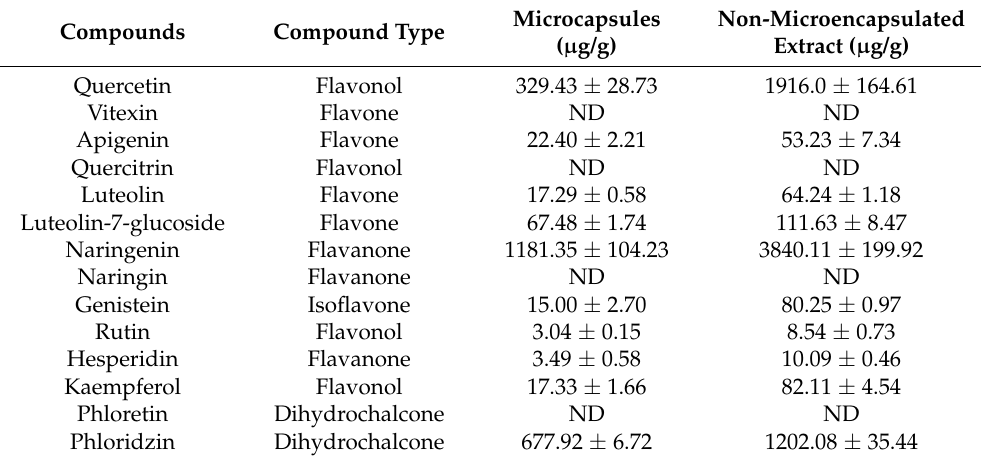
Table 4. Identification and quantification of flavonoids in oregano ( Lippia graveolens ) microcapsules. Compounds Compound